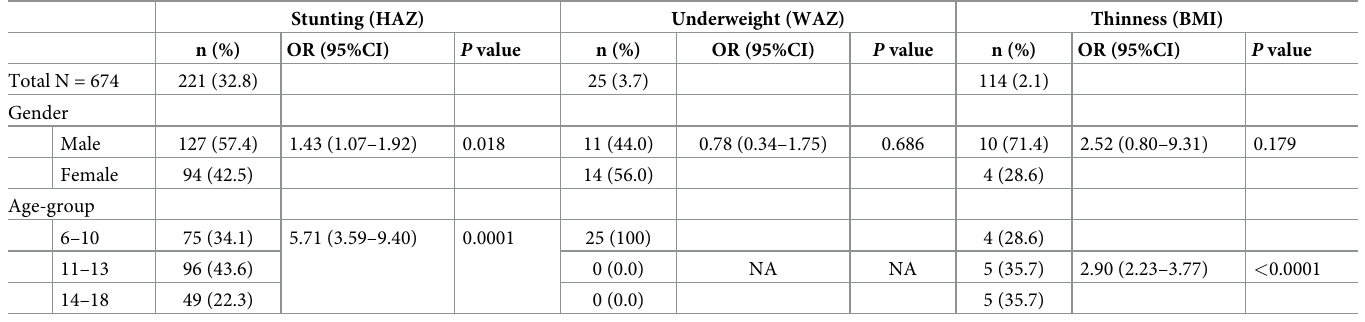
Table 1. Nutritional status by gender and age groups.